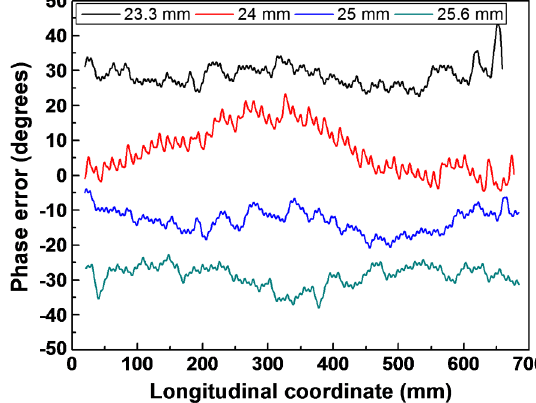
7. Measured peak-to-peak distances for four undulator periods.